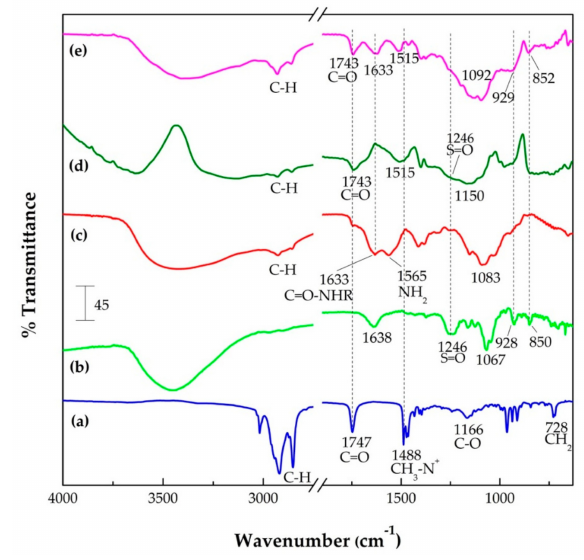
Figure 5. FTIR spectra of: ( a ) NE; ( b ) κ -CAR; ( c ) CS; ( d ) NE- κ -CAR; and ( e ) NE( κ -CAR/CS) 2